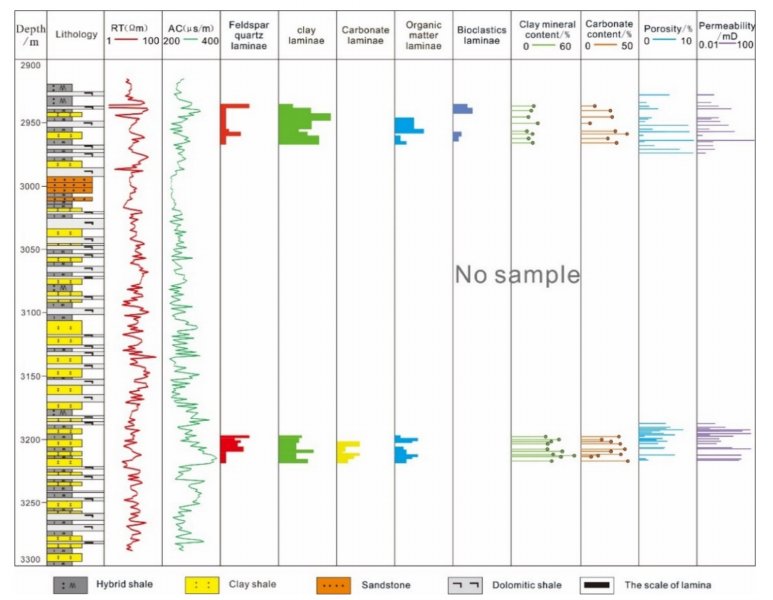
Figure 12. Laminae distribution of Well G108-8 in the second Member of the Kongdian Formation in Cangdong